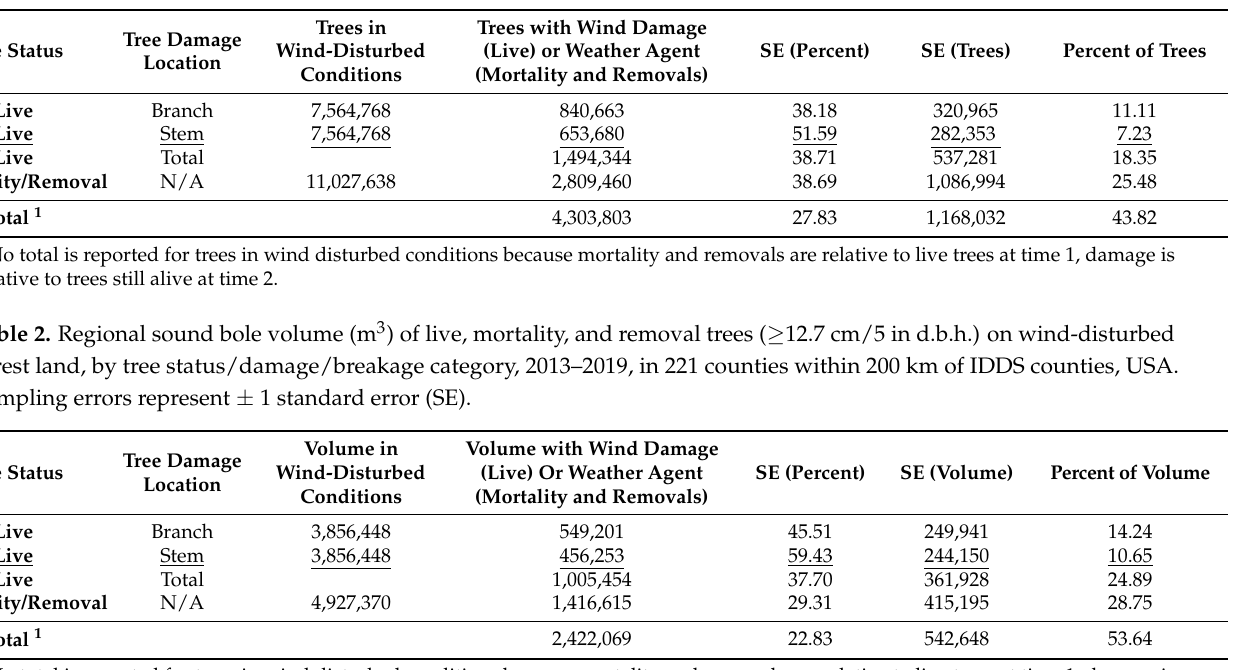
Table 1. Number of live, mortality, and removal trees ( ≥ 12.7 cm/5 in d.b.h.) on wind-disturbed forest land, by tree status/damage/breakage category, 2013–2019, in 221 counties within 200 km of IDDS counties, USA. Sampling errors represent ± 1 standard error (SE).